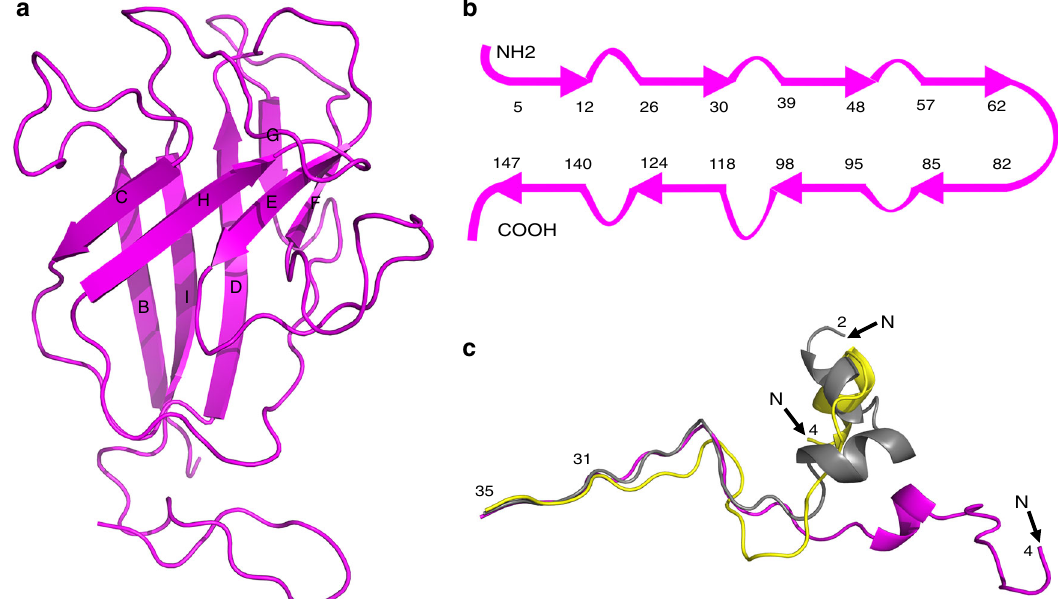
Fig. 2 Structures of the penton protein (P1) and the MCPs. a Ribbon diagram of the penton protein. b Diagrammatic representation of the arrangement of β -strands in the penton protein. Residues are numbered at the ends of the β -strands. c Different conformational arrangements of the N terminus of the MCP. The Vp54 subunit structure of capsomer a (yellow) and capsomer b (magenta) are superimposed on the crystal structure of Vp54 (gray). Only the N-terminal 35 residues of each are shown for